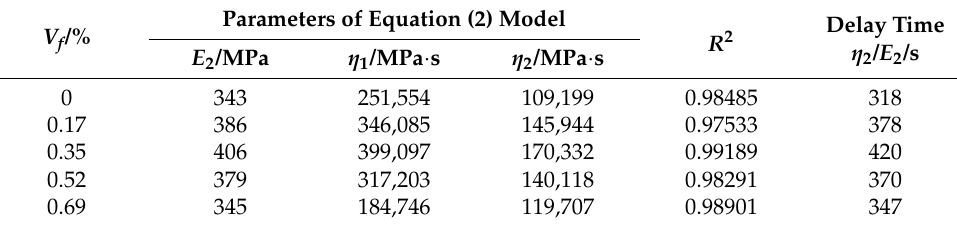
Table 3. Equation (2) model parameters of asphalt composite concrete with different V f .